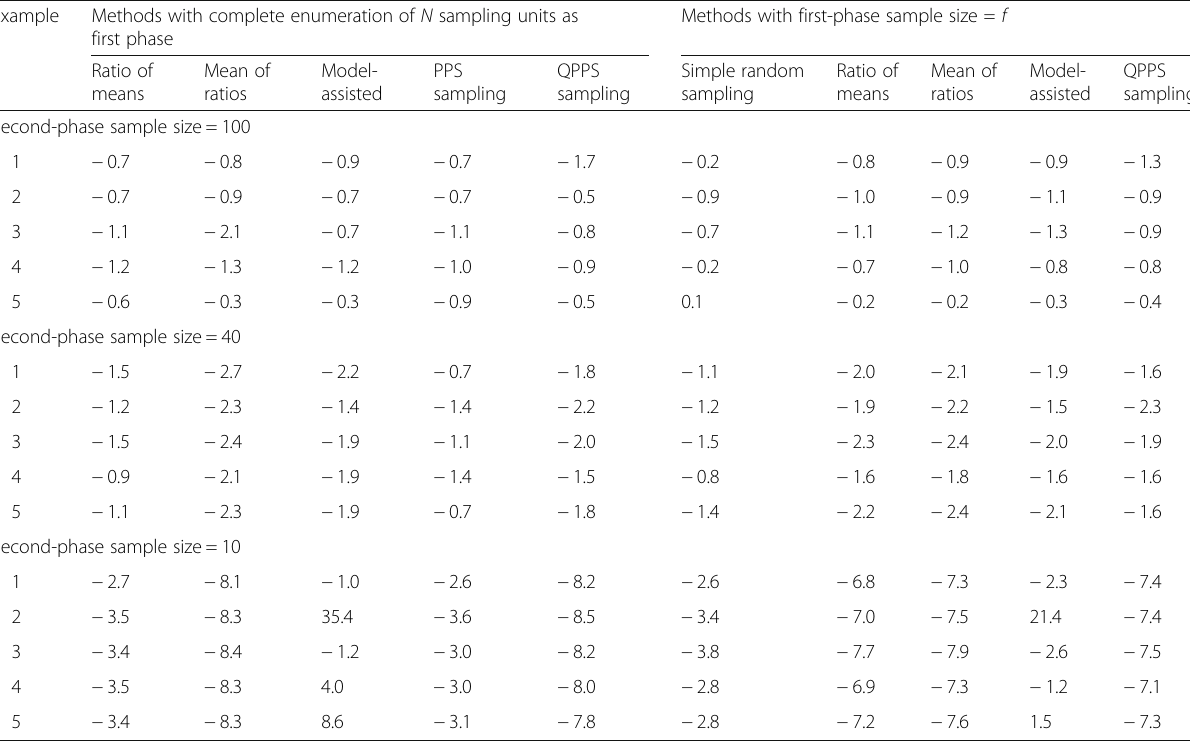
Table 4 Bias (%) in estimates of standard errors of estimates of the population mean for the various methods considered here Example Methods with complete enumeration of N sampling units as first